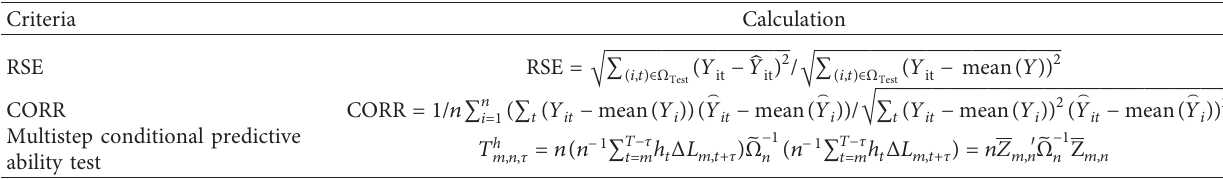
Table 1: Performance criteria and their calculations.